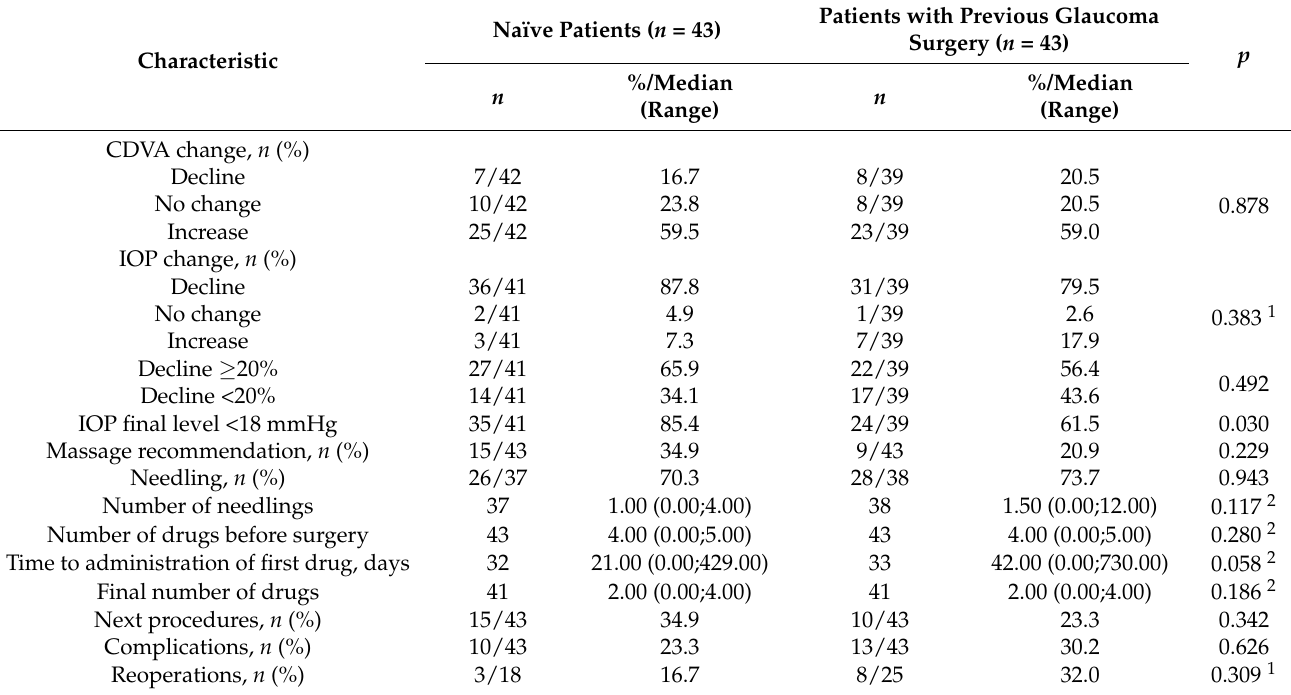
Table 3. Clinical characteristics of the study